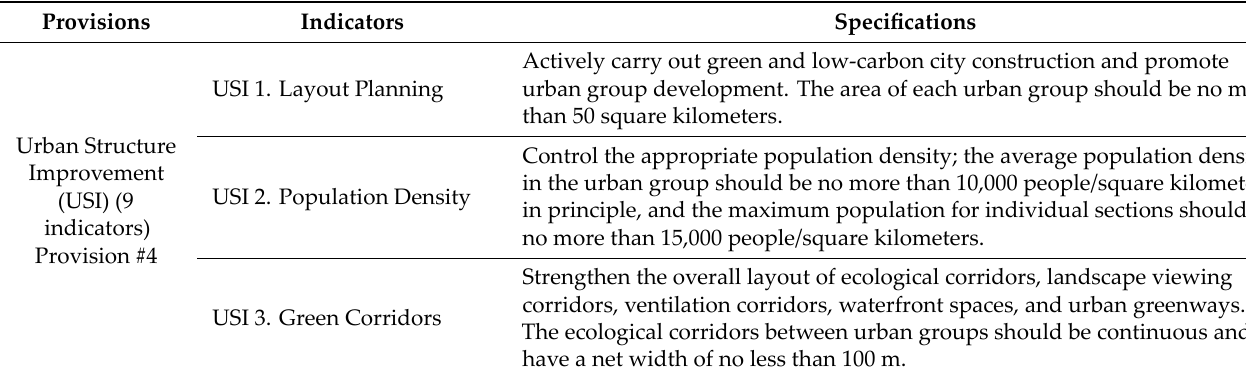
Table A1. Specifications of the included